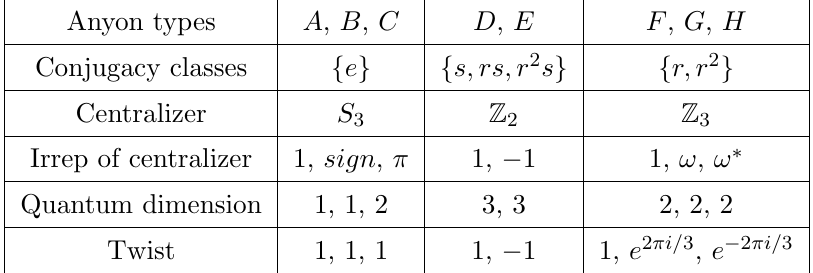
Table 2 . Information of anyons of the D ( S 3 ) model. Anyons of types A; B , and C are pure charges, D and F are pure (cid:13)uxes, and E; G; H are